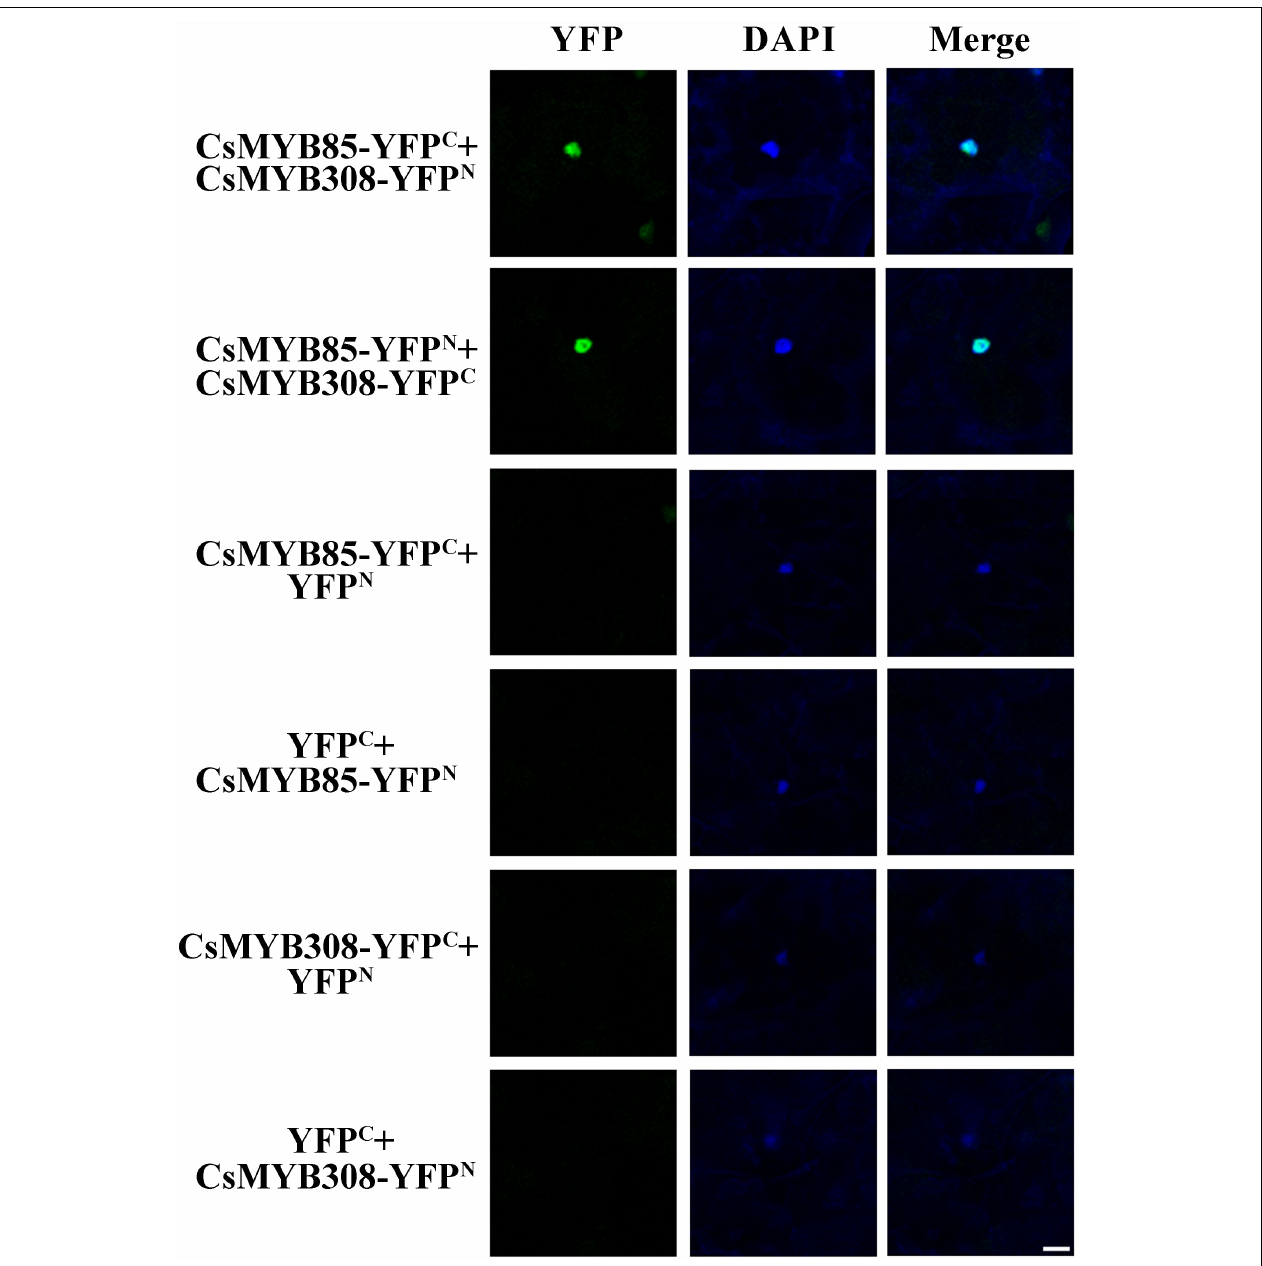
FIGURE 6 | Interaction between CsMYB85 and CsMYB308 determined using a BiFC assay. CsMYB85 and CsMYB308 were fused with C -terminal yellow fluorescent protein (YFP C ) and N -terminal YFP (YFP N ), respectively, and driven by the CaMV35S promoter. The vectors were introduced into Nicotiana benthamiana leaves by agroinfiltration. YFP fluorescent signals were imaged under a confocal microscope 72 h after infiltration. Panels from left to right: YFP signal (YFP), 4 (cid:48) ,6-diamidino-2-phenylindole (DAPI) nuclear staining signal, and merged YFP and DAPI signals. Empty vectors (YFP C and YFP N ) and the aforementioned vectors were co-expressed in epidermal cells as a control. Bar = 50 µ